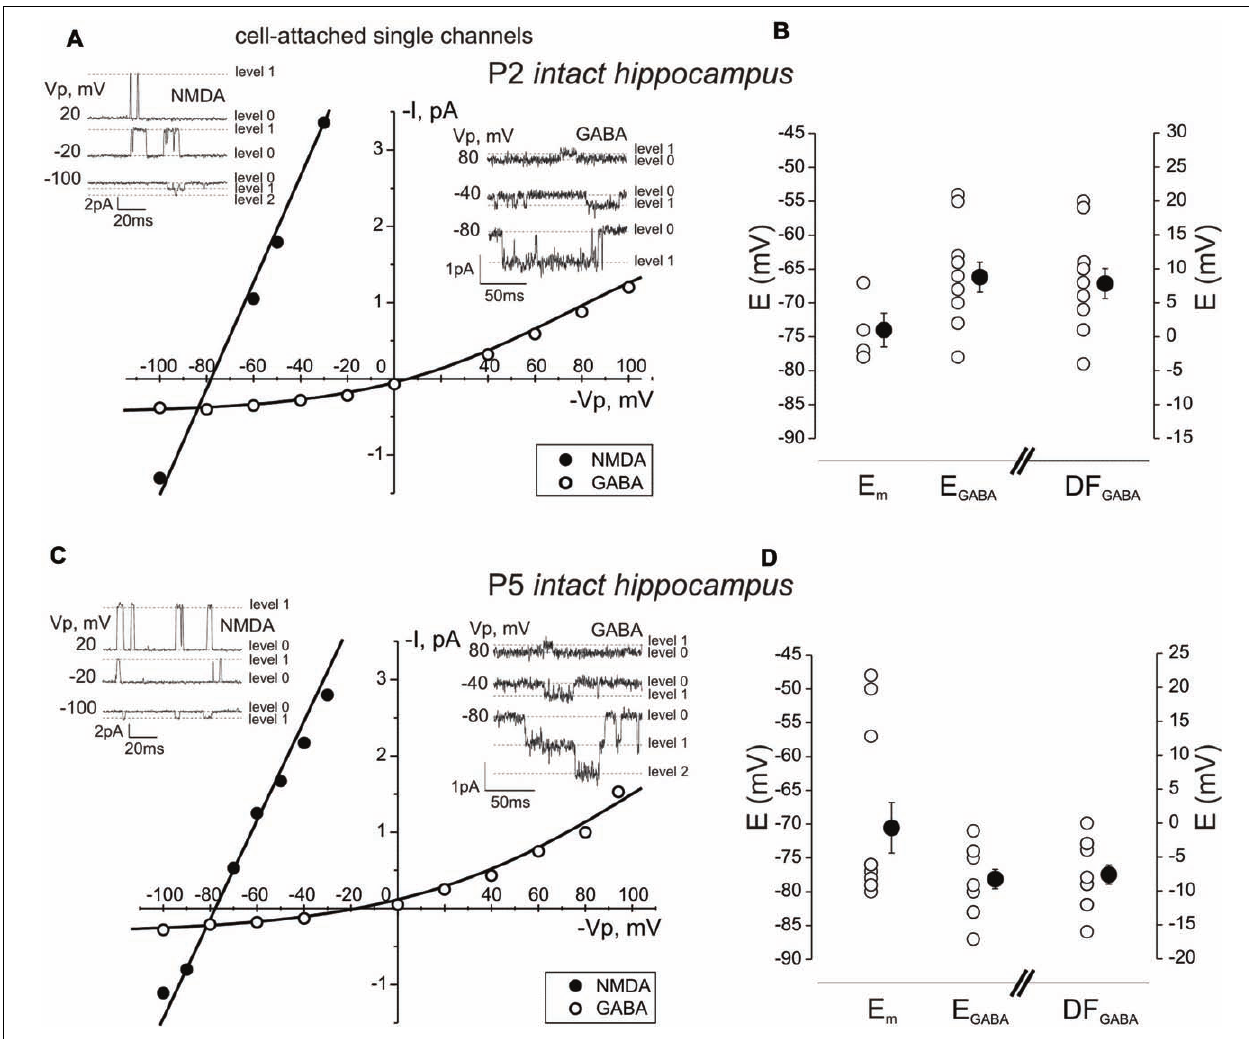
FIGURE 4 |Age-dependence of the GABA driving force and resting membrane potential in CA3 pyramidal cell layer neurons of the intact hippocampus. (A,C) Measurements of the GABA driving force (DF GABA ) and membrane potential ( E m ) using cell-attached recording of GABA(A) and NMDA channels in the CA3 pyramidal cell layer neurons in P2 (A) and P5 (C) rat intact hippocampi. Recordings of single channel openings (levels are indicated with dashed lines: level 0 corresponds to closed state, level 1 – to the openings of single channels and level 2 – to the openings of two channels) at different pipette potentials ( V p )